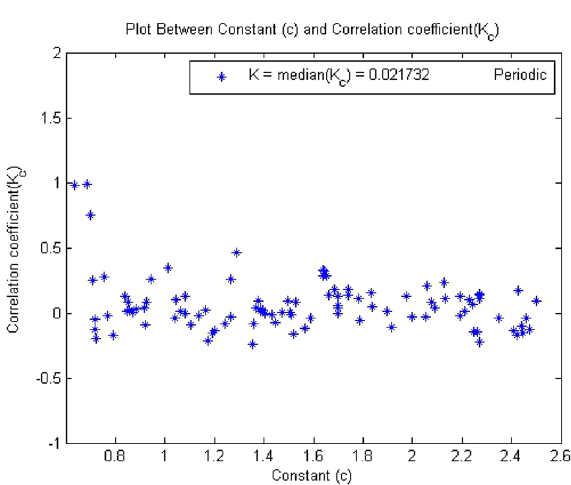
Figure 8. Plot of c vs K c shows periodic behavior as value of K =